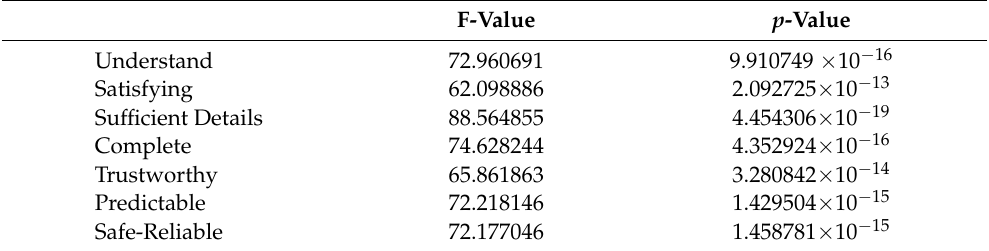
Table 4. Table of the F-values and p -values obtained in the Kruskal–Wallis test for the actual explanations.